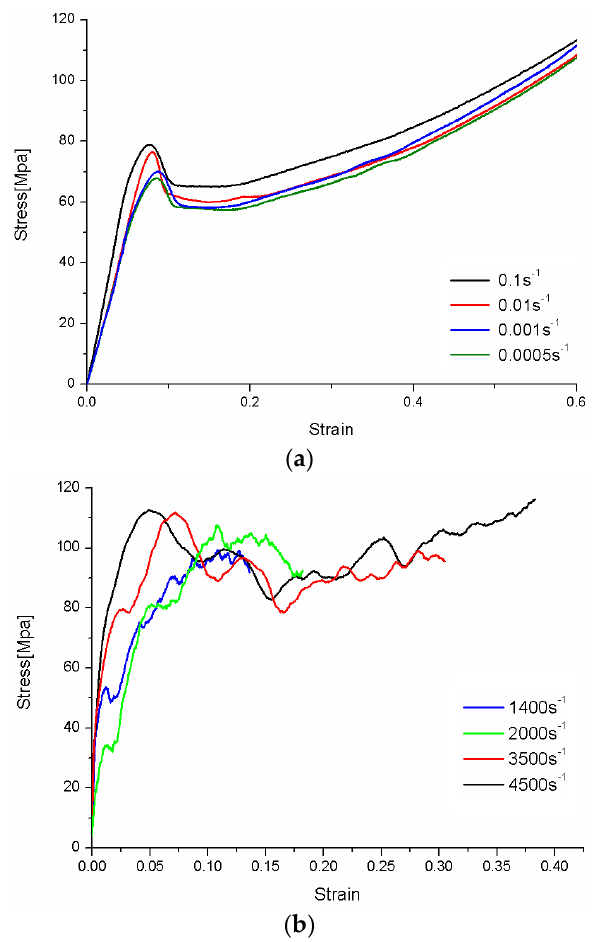
Figure 7. True tensile stress–true strain laws of PC: ( a ) quasi-static; and ( b ) dynamic.